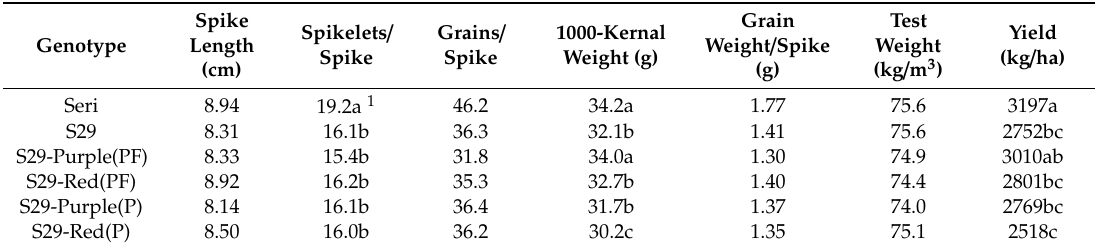
Table 4. Grain yield and spike productivity traits in purple grain isogenic lines across sites in 2017.